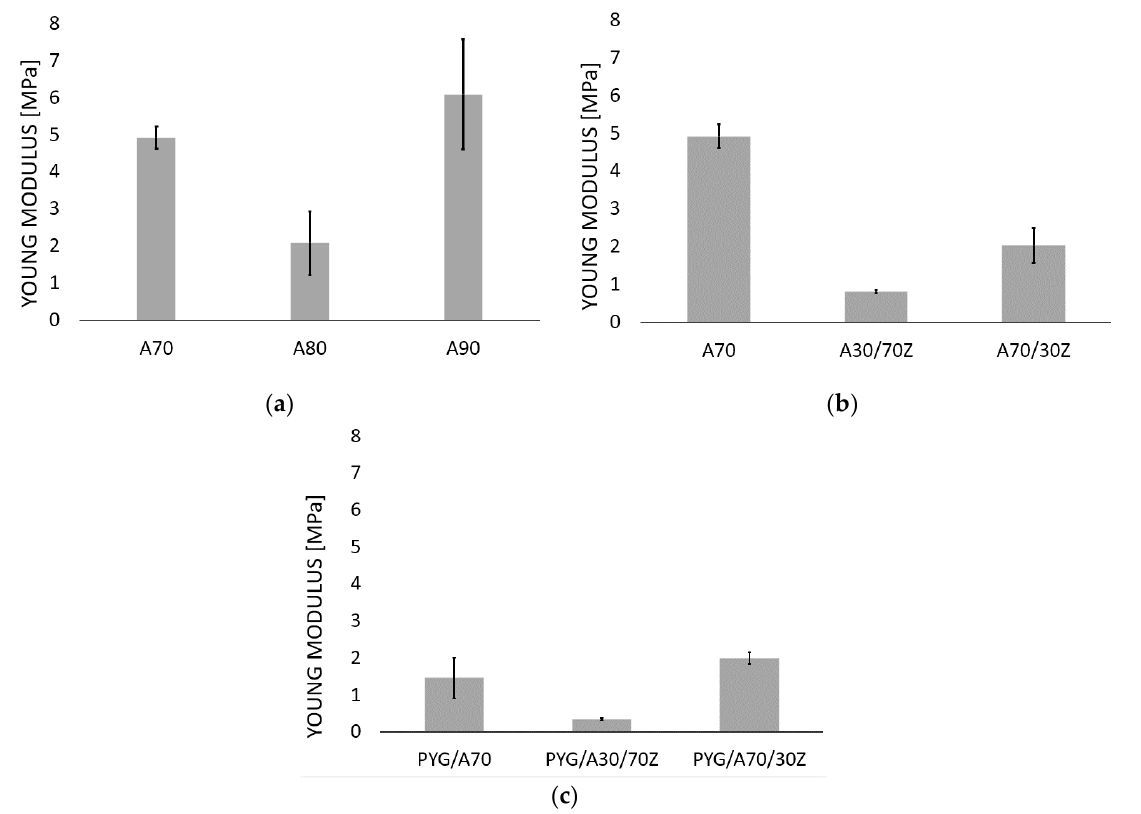
Figure 1. Young ’ s Modulus values for hydrogel samples consist of: ( a ) sodium alginate, ( b ) sodium alginate mixed with gelatin, ( c ) alginate mixed with gelatin, and the addition of the bark of African plum. All the tested samples were cross-linked with 1.5 mol barium chloride solution. Table 1. Summary of Young’s Modulus values of the tested samples about those described in the literature and human